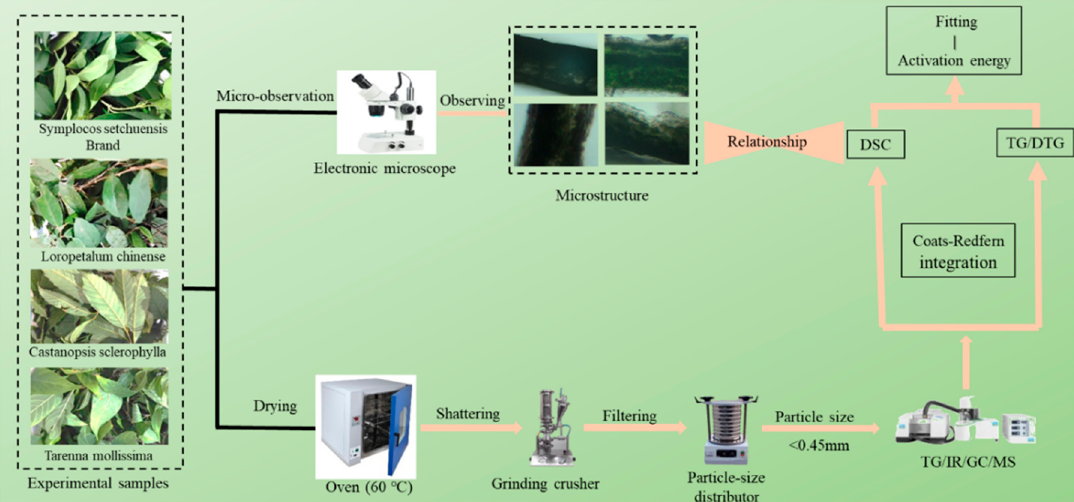
Figure 1. Experimental flowchart of samples.